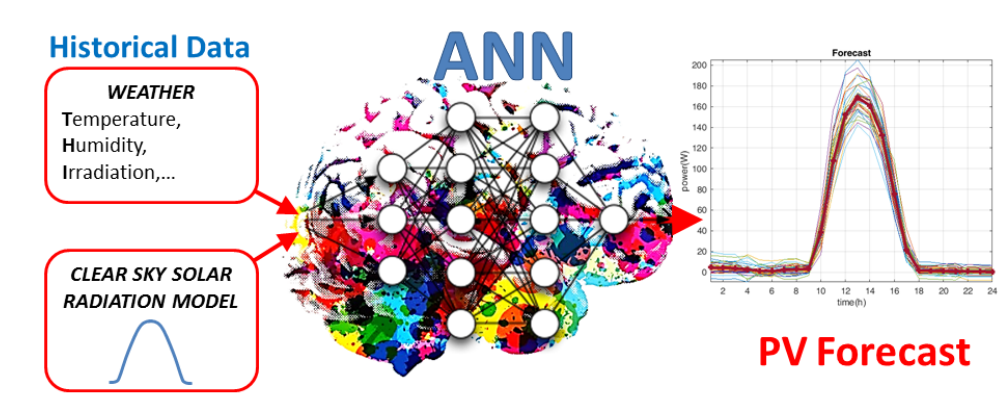
Figure 1. PHANN basic scheme.